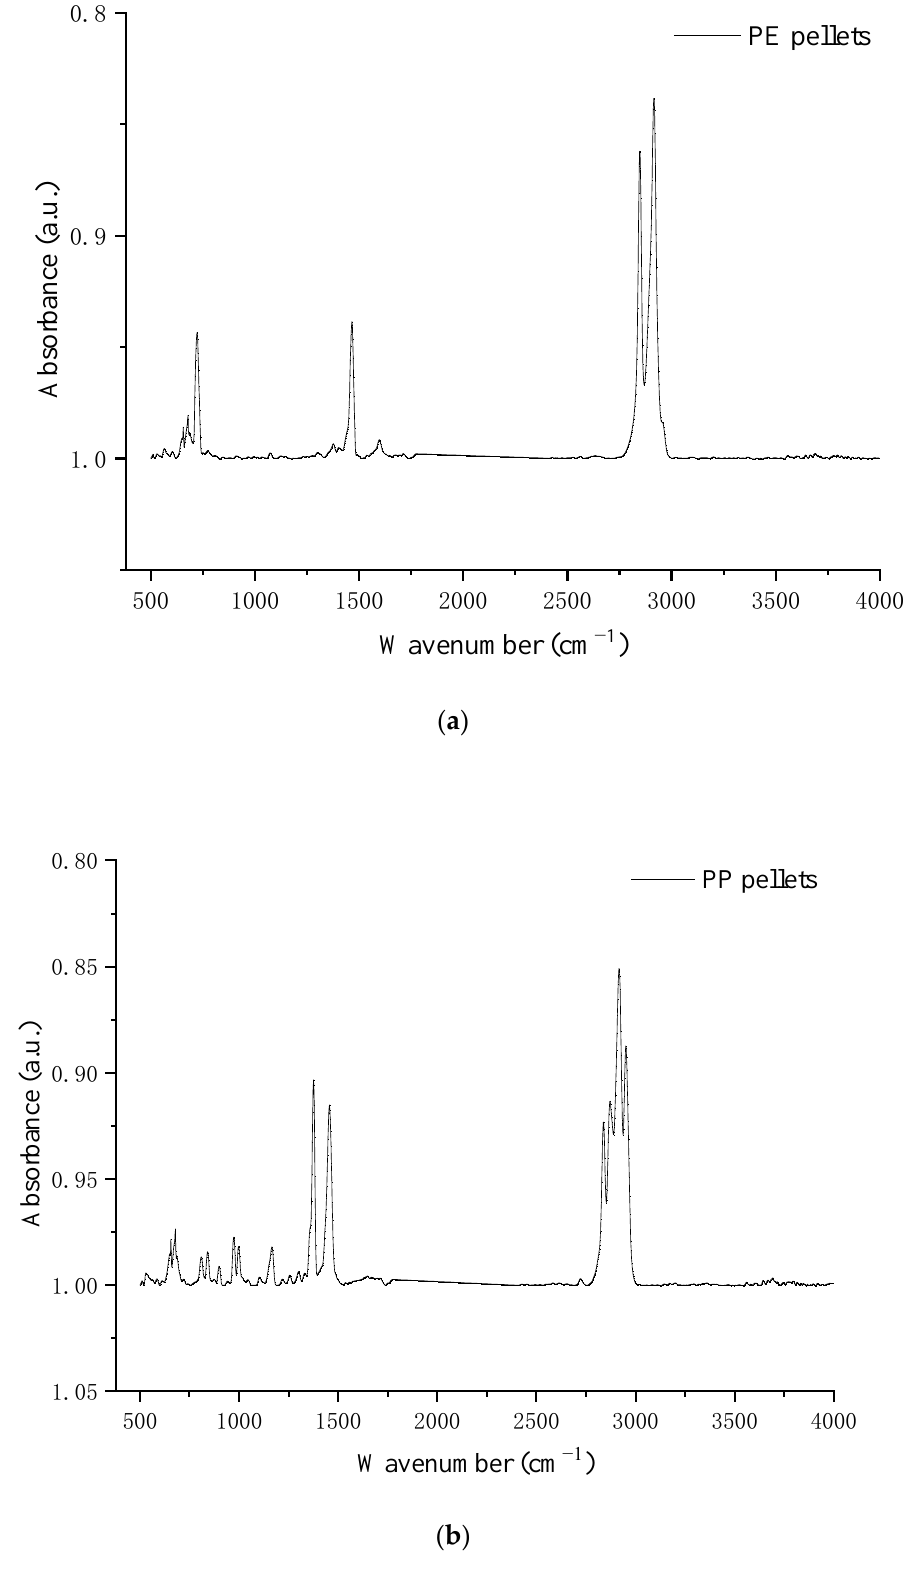
Figure 7. The functional groups change of different plastic pellets. ( a ) PE pellets. ( b ) PP pellets. The main characteristic peaks of plastic-modified asphalt and base asphalt were de- picted in Figure 8. When the asphalt was modified with PE and PP, the out-of-plane vi- bration of aromatic components was obvious, such as the C-H stretching vibration ab- sorption peaks of cycloalkanes and alkanes at 2850 cm −1 to 2990 cm −1 , the CH 3 and CH 2 variable angle vibration absorption peaks at 1450 cm −1 and 1370 cm −1 , and the absorption